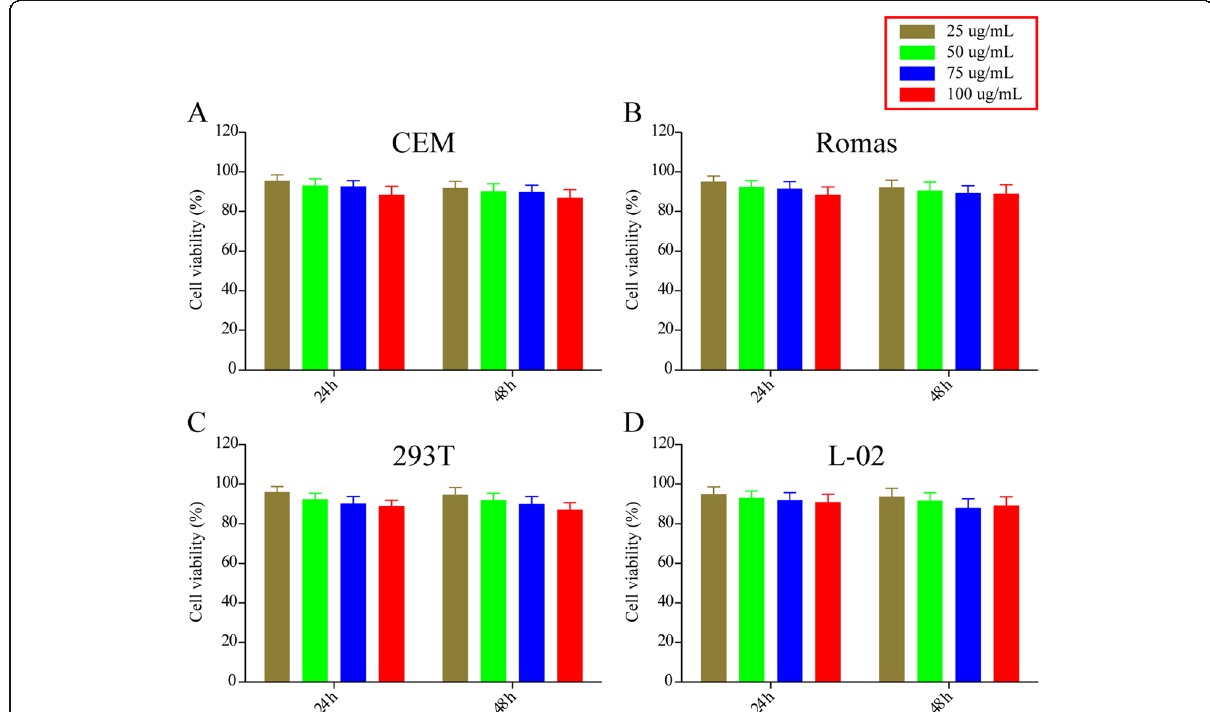
Fig. 6 In vitro cytotoxicity of MSNs. a CEM, b Ramos, c 293T, and d L-02 cells were treated with the indicated concentrations of MSN, and cell viability was